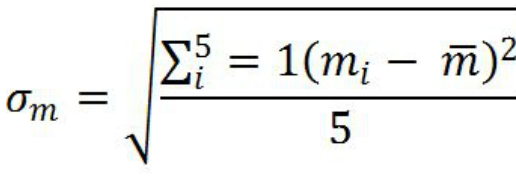
Figure 6. Sample size